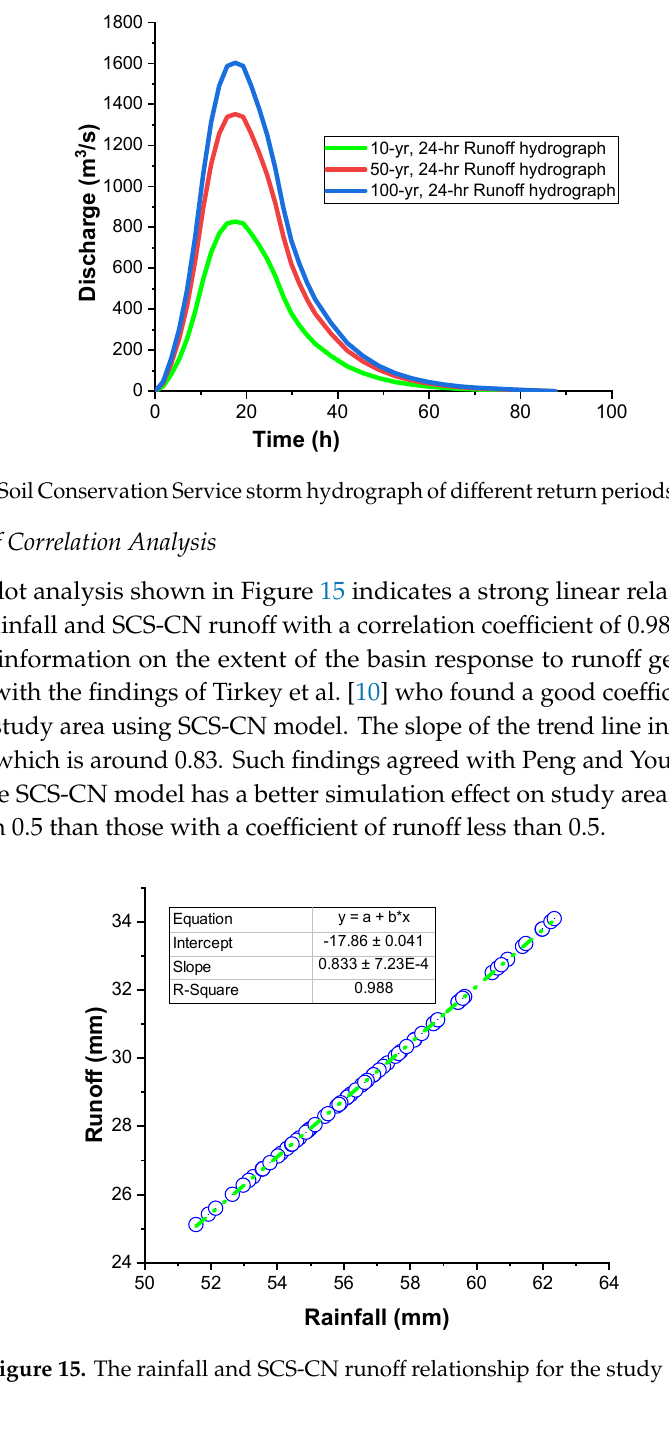
Figure 13. Potential runoff map of the study area.